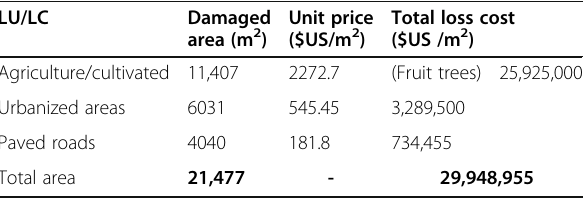
Table 4 The estimated economic cost of the damaged and losses of the valued